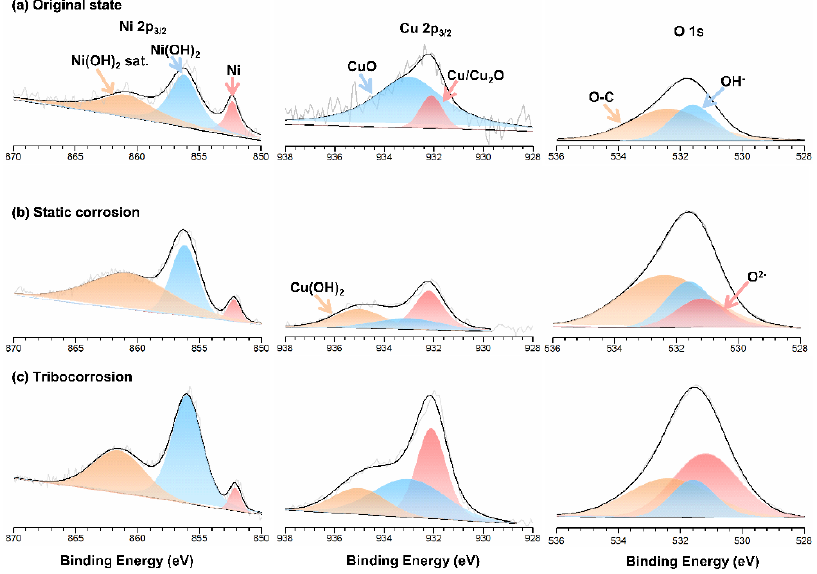
Figure 7. The XPS spectra of Ni 2p, Cu 2p and O 1s detected for corrosion products formed under the Table 3. The assignment, binding energy and proportion of characteristic peaks from XPS analysis.